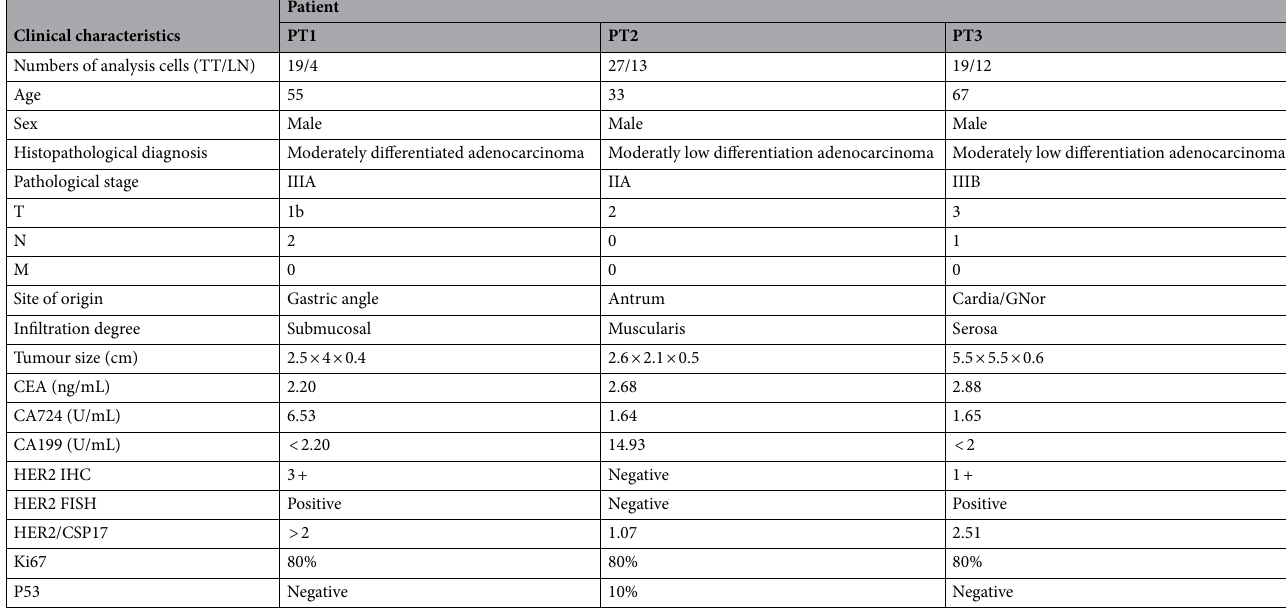
Table 1. Clinical characteristics of each patient used in the scRNA-seq study and the cell number of each sample after quality control. PT patient, TT tumour tissue, LN lymph node, CEA carcinoembryonic